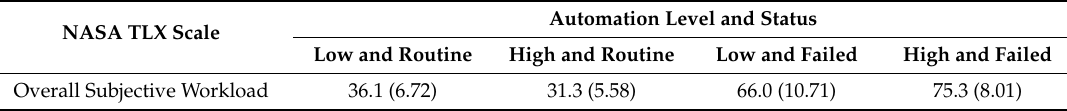
Table 2. Overall subjective workload by automation level and status.